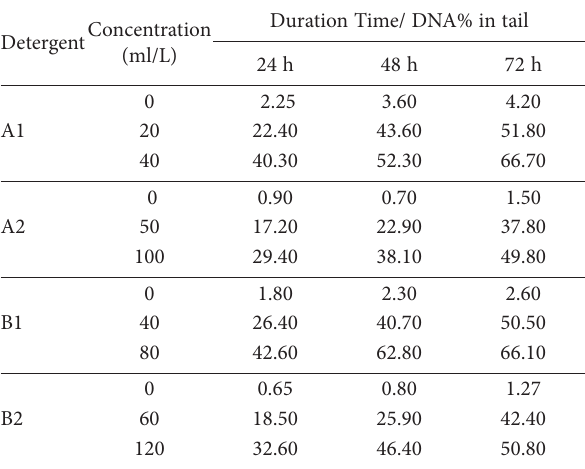
Table 5. The effect of the detergents on Tail DNA percentages in V. faba DetergentConcentration (ml/L)